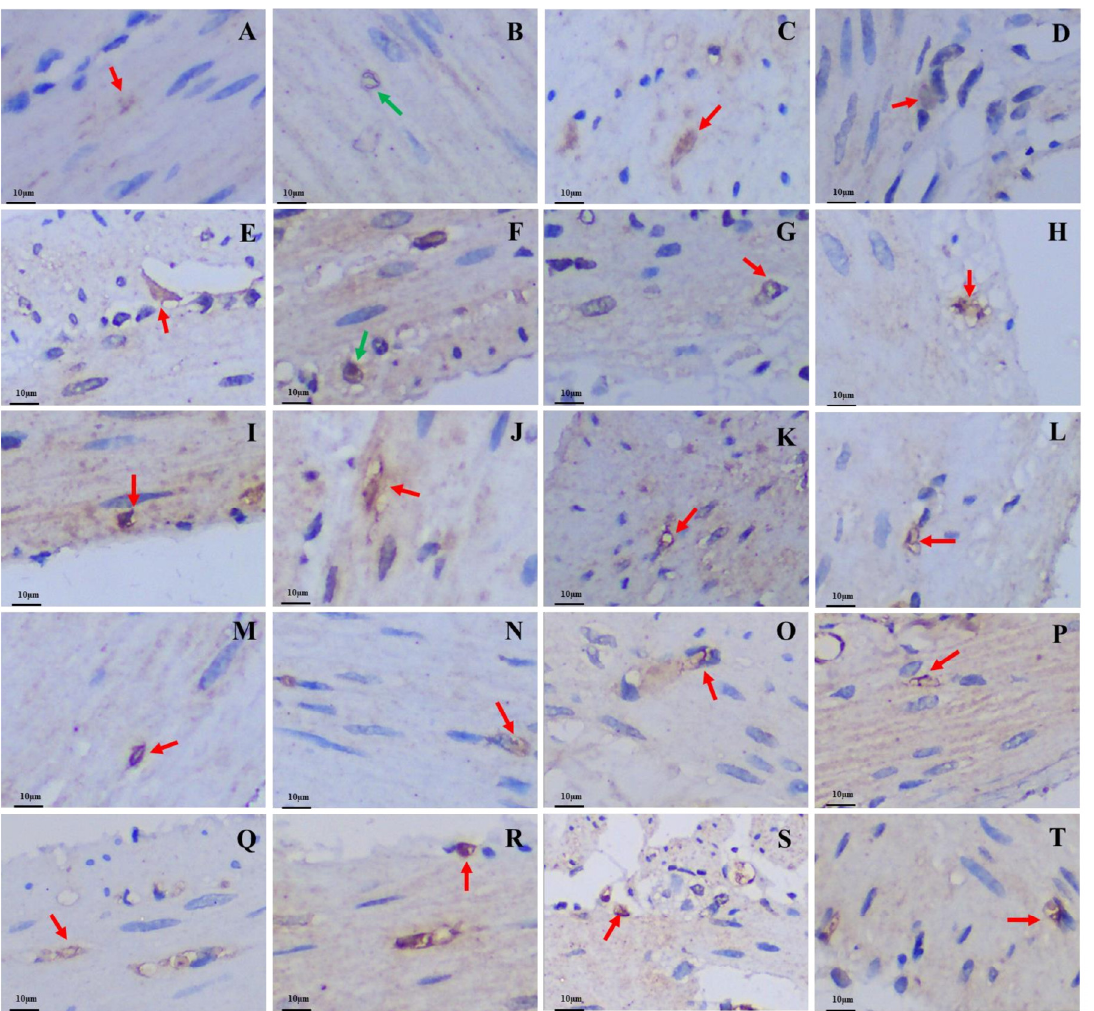
Figure 6. Distribution and morphology of Glu-immunoreactive cells in the GIT of the plateau zokor and plateau pika (400× magnification). ( A – J ) Followed by the fundus of stomach, corpus I of stomach, corpus II of stomach, pylorus of stomach, duodenum, jejunum, ileum, colon, rectum, and cecum of the plateau zokor; ( K – T ) similarly, the plateau pika’s gastrointestinal organs. The red arrow indicates opened-type argyrophilic cells and the green arrow indicates closed-type argyrophilic cells.